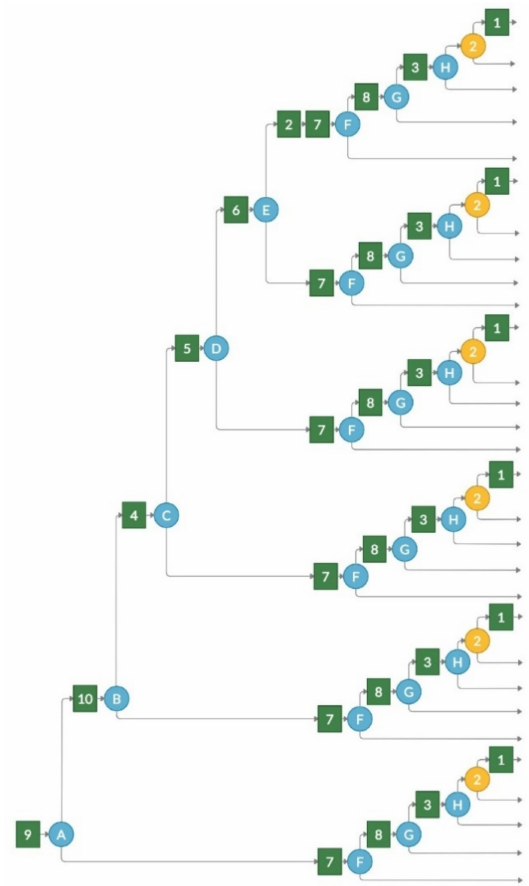
Figure A4. Result of modified contextual graph transformation to a tree structure for graph, presented in Figure